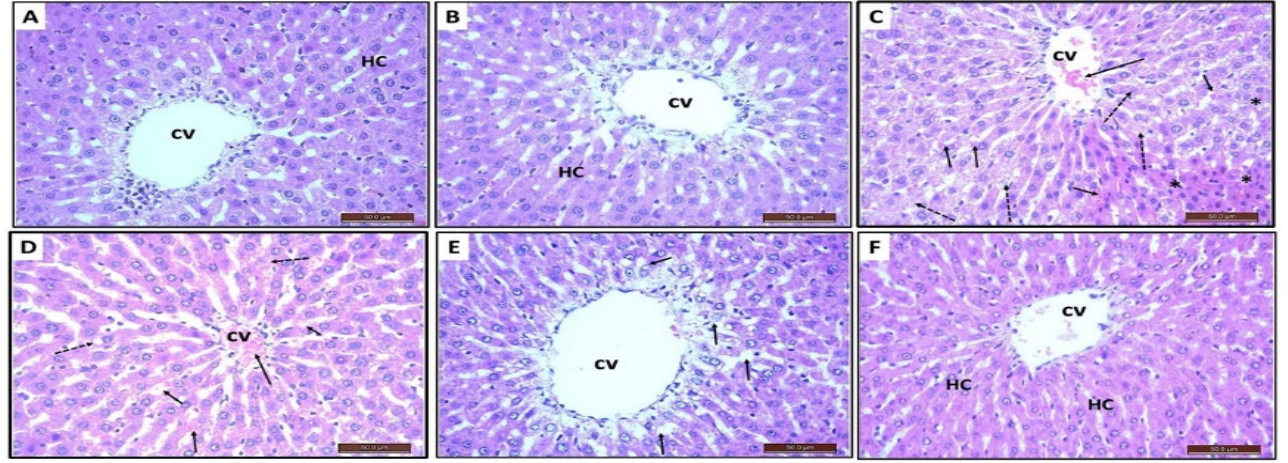
Figure 3. Photomicrographs of liver sections of all study groups stained with H&E. ( A , B ): control and OLE group showing the normal histological structure of hepatic lobules. ( C ): Cis group showed vacuolar degenerative changes in many hepatocytes (dashed arrow), congestion of central vein (long arrow), and sinusoid (short arrow). Many hepatocytes accumulate in irregular patterns disrupting the normal arrangement of hepatic cords (asterisks). ( D – F ): Cis + OLE, Cis + CM-MSC, and Cis + MSC groups, respectively show restoration of the normal hepatic structure in all the three groups, which is clearly seen in both Cis + CM-MSC, and Cis + MSC groups. Central vein (CV)-normally arranged hepatocyte cords (HC). ×